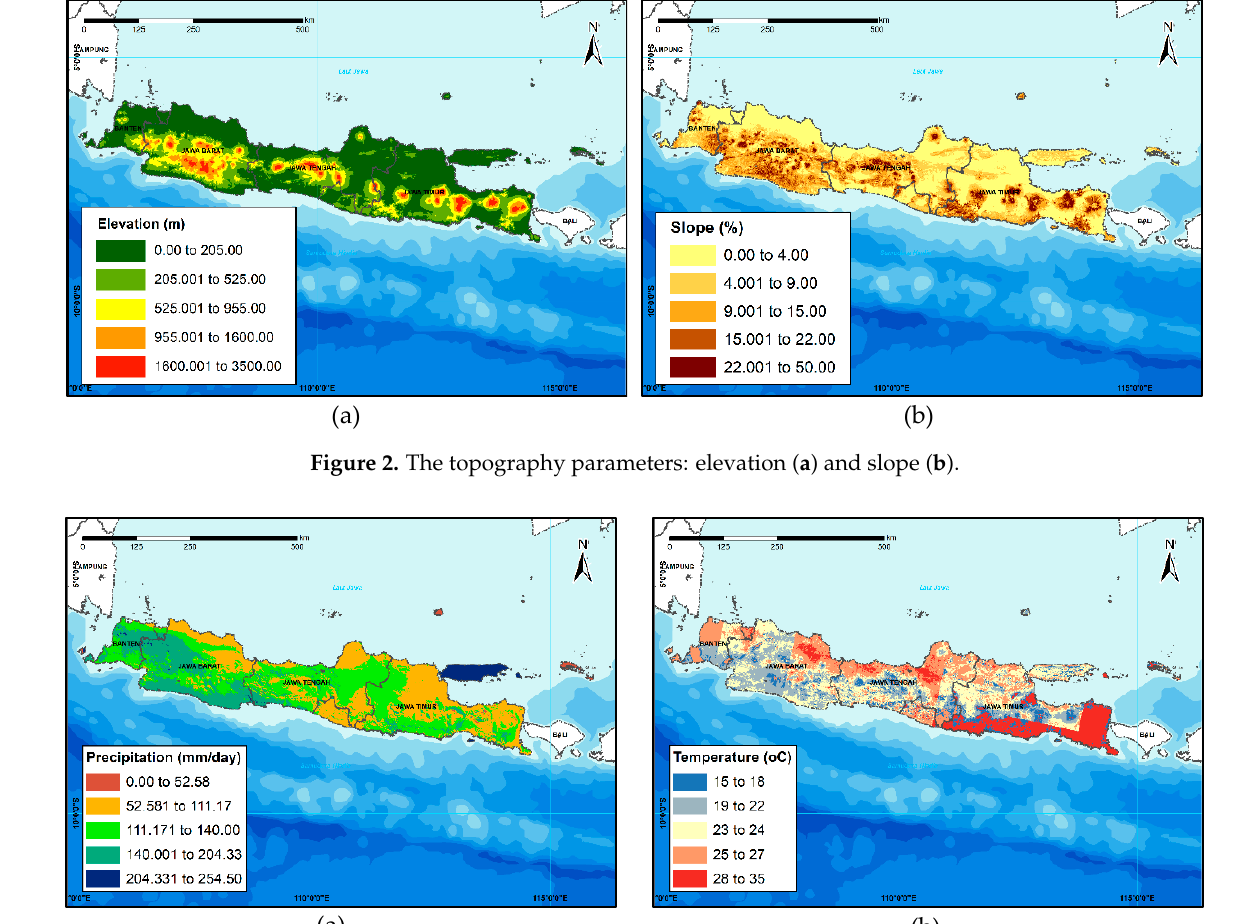
(d) Figure 4. The soil characteristics: soil organic carbon (SOC) ( a ), soil pH ( b ), soil type ( c ), and ecoregion ( d ).